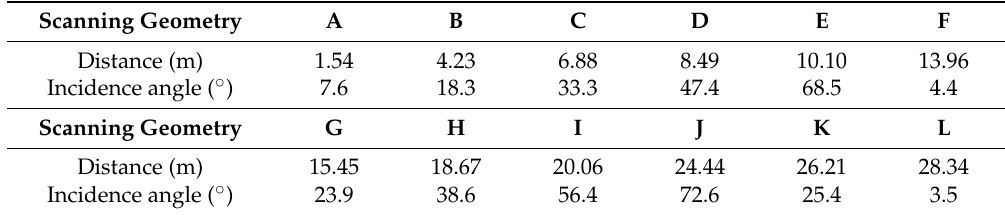
Table 2. Four reference targets scanned at other incidence angles and distances referred to